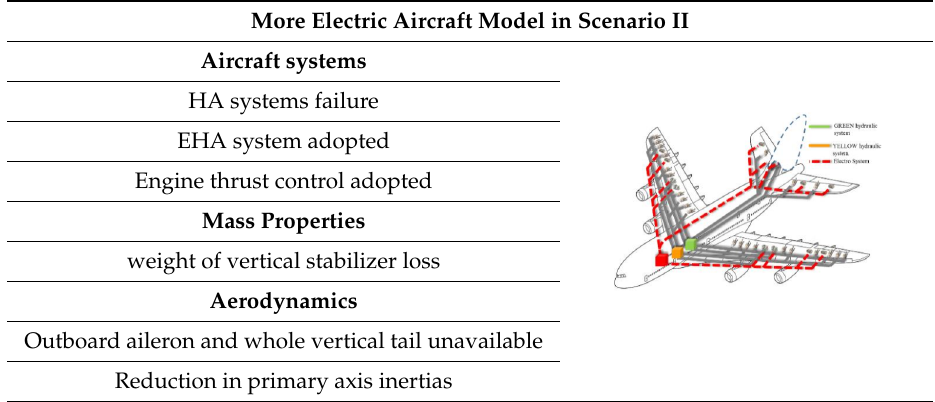
Table 2. Scenario II damage e ff ects towards the